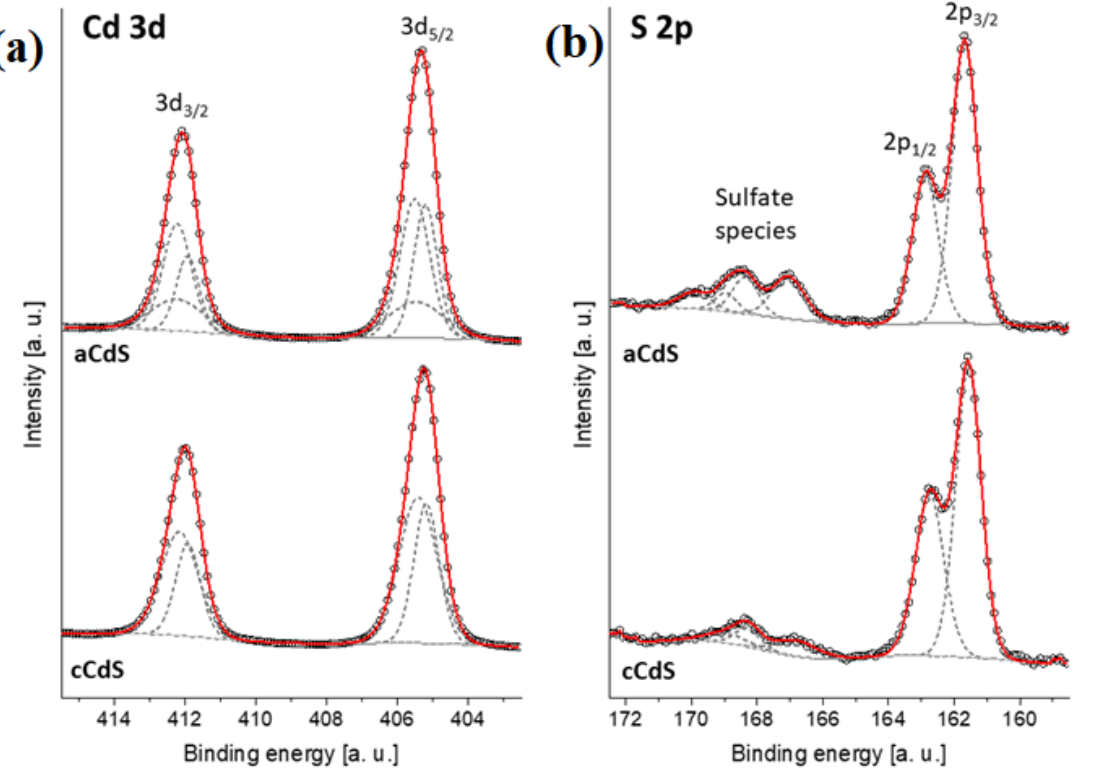
Figure 3. Core level emissions of ( a ) Cd 3d and ( b ) S 2p from the XPS spectra of mechanochemically synthesized aCdS and cCdS powders.